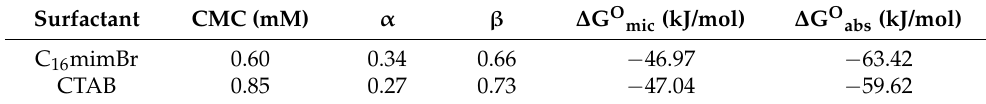
Figure 5. Conductivity versus concentration for C 16 mimBr ( left ) and CTAB ( right ) at 25 °C. Table 5. Thermodynamic parameters derived from conductivity data.